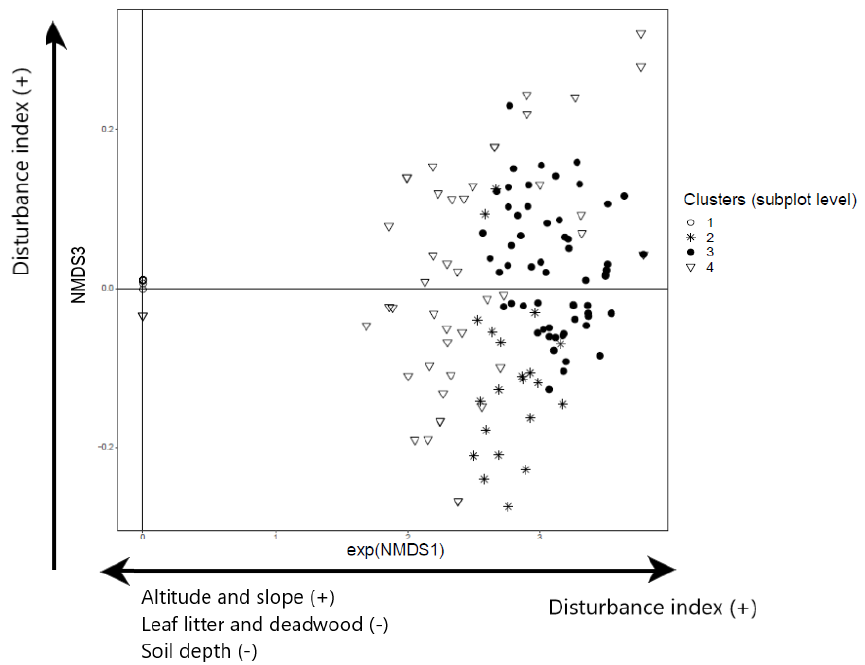
Figure 4. NMDS ordination (axes 1 and 3) of 147 subplots across six sacred forests for understory saplings and shrubs. Subplots are labeled according to the four clusters produced by the cluster analysis (1: Fagus sylvatica ; 2: Carpinus orientalis / Acer monspessulanum ; 3: no significant species; 4: Carpinus betulus / Ostrya carpinifolia ). The first axis of the NMDS ordination was transformed as exp(NMDS) to improve readability. Arrows indicate the main forest prohibition regimes and environmental variables statistically related to the axis coordinates. An increase in the “disturbance index” points to forest prohibition regimes allowing higher levels of disturbance (increased wood removal and